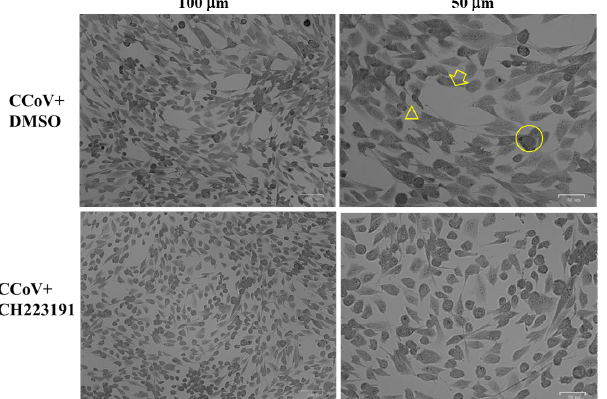
Figure 3. AhR inhibitor CH223191 reduces morphological cell death signs during CCoV infection in A72 cells. Cells were infected with CCoV, in the presence or absence of CH223191. At 24 h p.i., cells stained by Giemsa were analyzed under a light microscope. Photomicrographs showing in unexposed infected groups, some cells with cell death features, such as an increase in intercellular spaces due to detachment from culture plate (arrow). In addition, morphological apoptotic marks, such as cell shrinkage (arrowhead), pyknosis and chromatin condensation (circle), were detected. In the presence of AhR inhibitor, all those cell death features were markedly diminished in CCoV-infected cells.